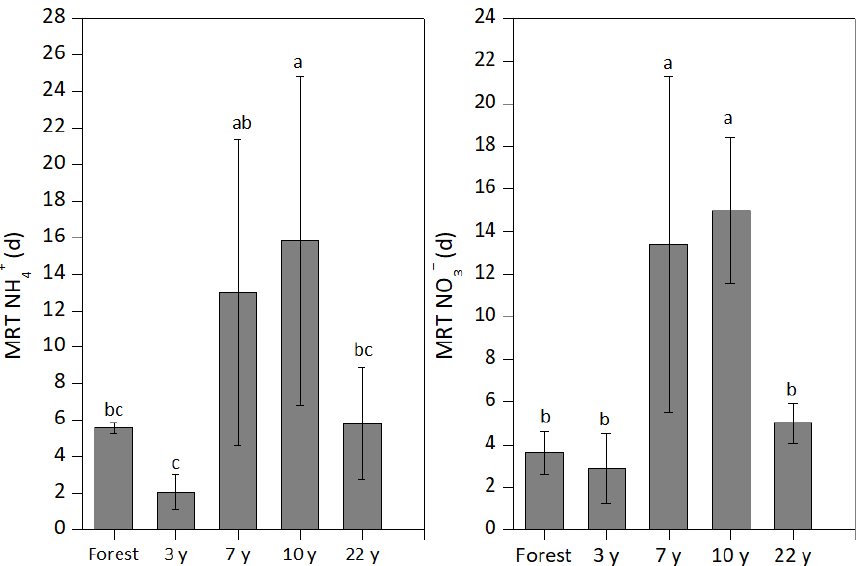
Figure 3. Mean residence times of NH 4+ (MRT NH 4+ ) and NO 3 − (MRT NO 3 − ) in soils under natural forest conditions and in banana plantations with different cultivation durations. Identical letters for MRT NH 4+ and MRT NO 3 − indicate there were no significant differences in soils under natural forest conditions and in the four banana plantations in the same region, at p = 0.05.